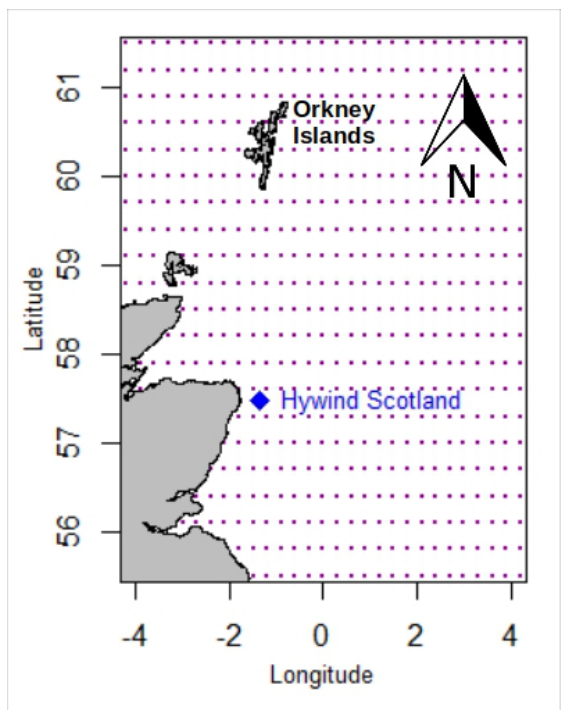
Figure 2. Study area and ERA5 gridpoints over Northeastern Scotland.